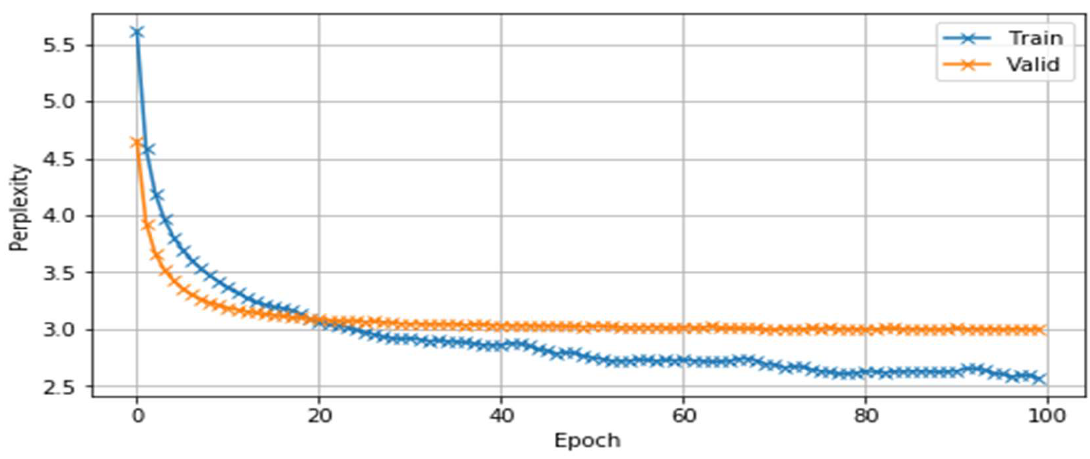
Figure 10. Changing perplexity of the model during learning stages.